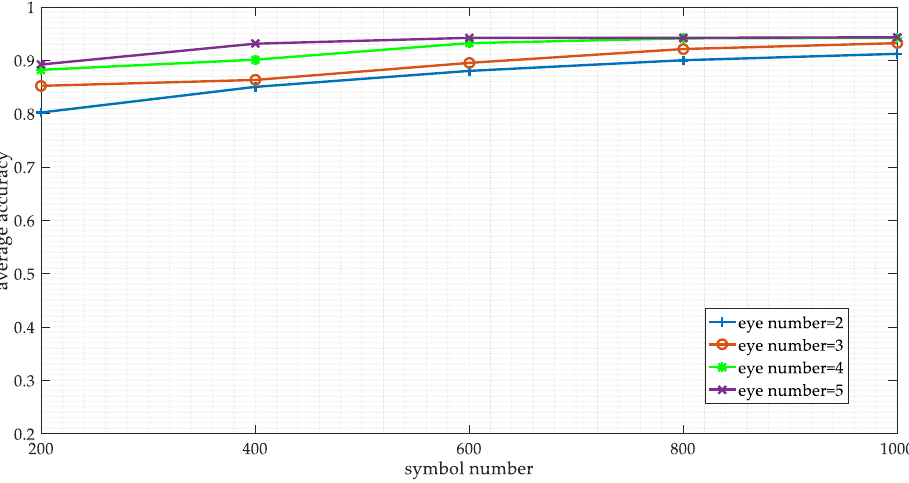
Figure 16. The network performance on the different sample parameters.